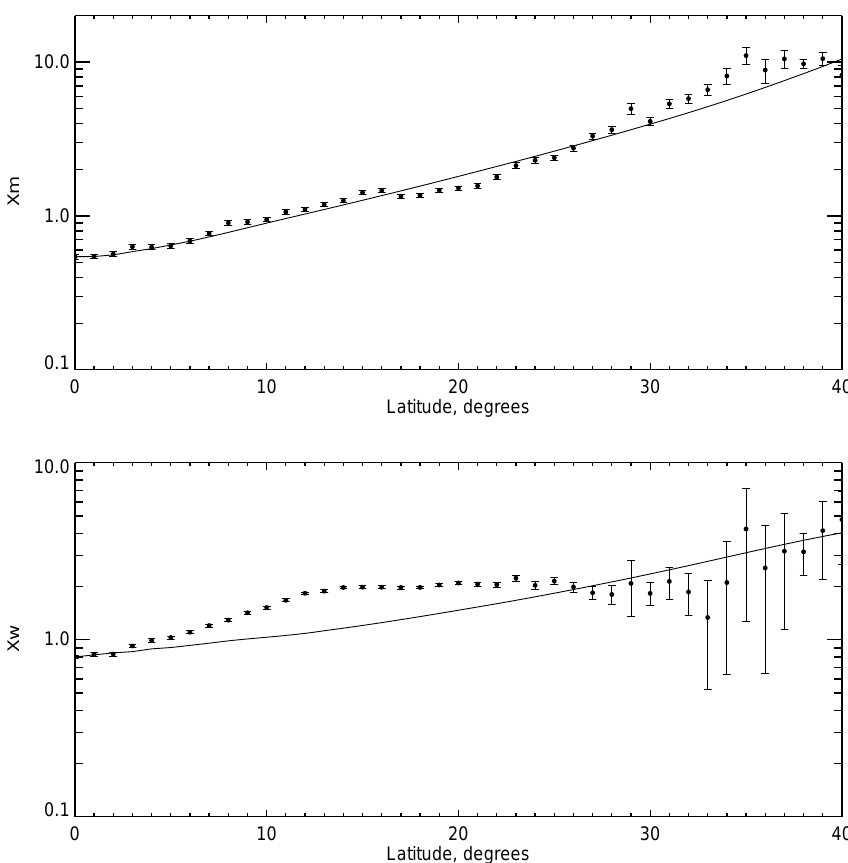
Fig. 5. Mean value X m (top panel) and variance X w (bottom panel) of the tan θ distribution, as a function of magnetic latitude. This figure shows the comparison between values obtained making use of Cluster data (circles) and numerical computations (solid